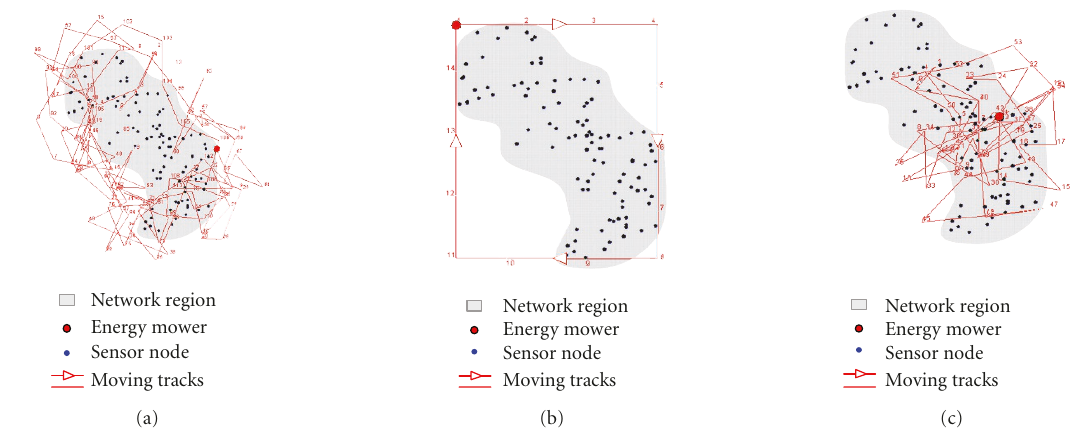
Figure 11: An example of the moving tracks of the energy mower that employed di ff erent moving strategies in an irregular network. (a) HUMS; (b) peripheral moving strategy; (c) random moving strategy.